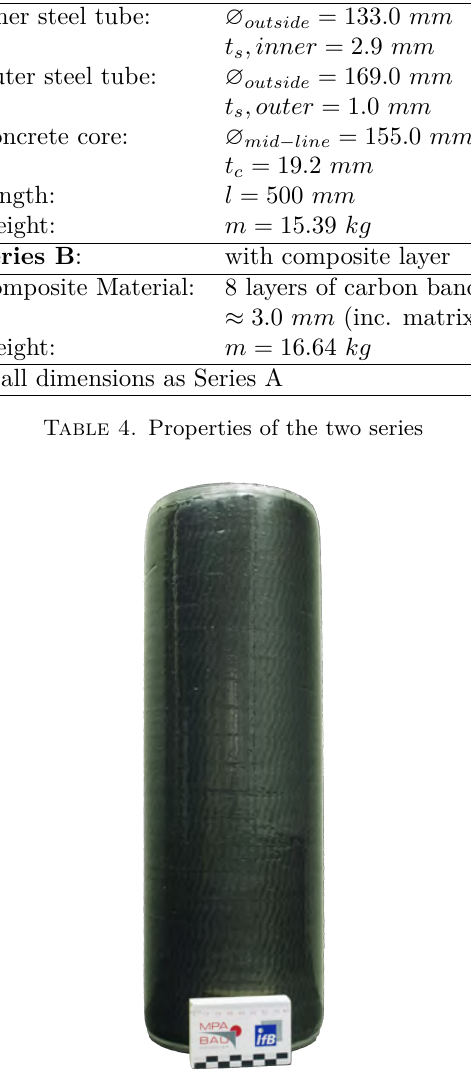
Figure 3. Specimen of Series B